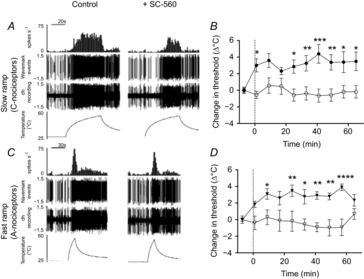
COX-1 inhibition in the VL-PAG results in a significant increase in firing thresholds to both C- and A-nociceptor activationA, digitised traces of raw data displaying responses of a moderate C+ve neuron to C-nociceptor activation, before and after administration of SC-560 into the VL-PAG. B, SC-560 administration into the VL-PAG resulted in an increase in response threshold of dorsal horn neurons to C-nociceptor activation compared to vehicle. C, digitised traces of raw data displaying responses of a moderate C+ve neuron to A–nociceptor activation, before and after administration of SC-560 into the VL-PAG. D, SC-560 administration into the VL-PAG resulted in an increase in response threshold of dorsal horn neurons to A-nociceptor activation compared to vehicle. Data are mean ± SEM. *P < 0.05, **P < 0.01, ***P < 0.001, ****P < 0.0001, two-way ANOVA plus post hoc Bonferroni tests.